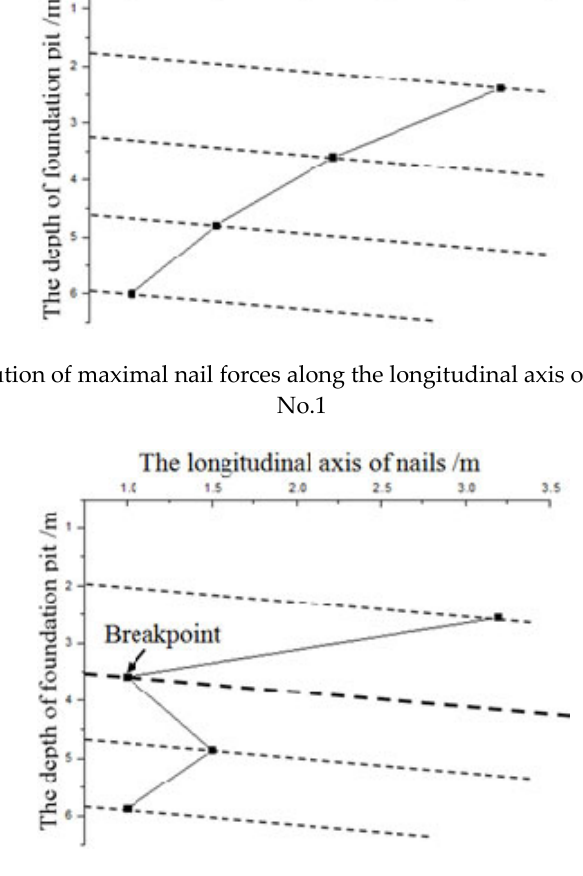
Figure 16. The distribution of maximal nail forces: ( a ) Section No.1; ( b ) Section No.4.